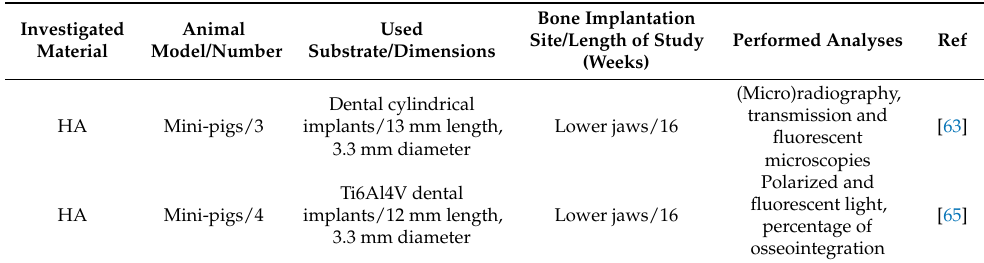
Table 5. Information related to the investigated coating materials, according to the applied small animal models (i.e., mini-pigs).